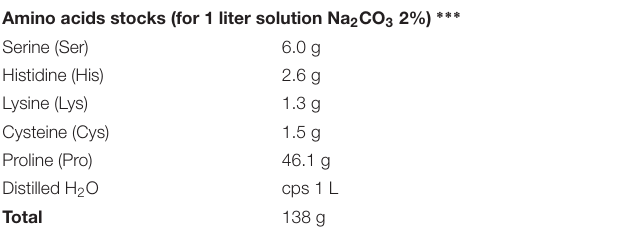
Frontiers in Microbiology |